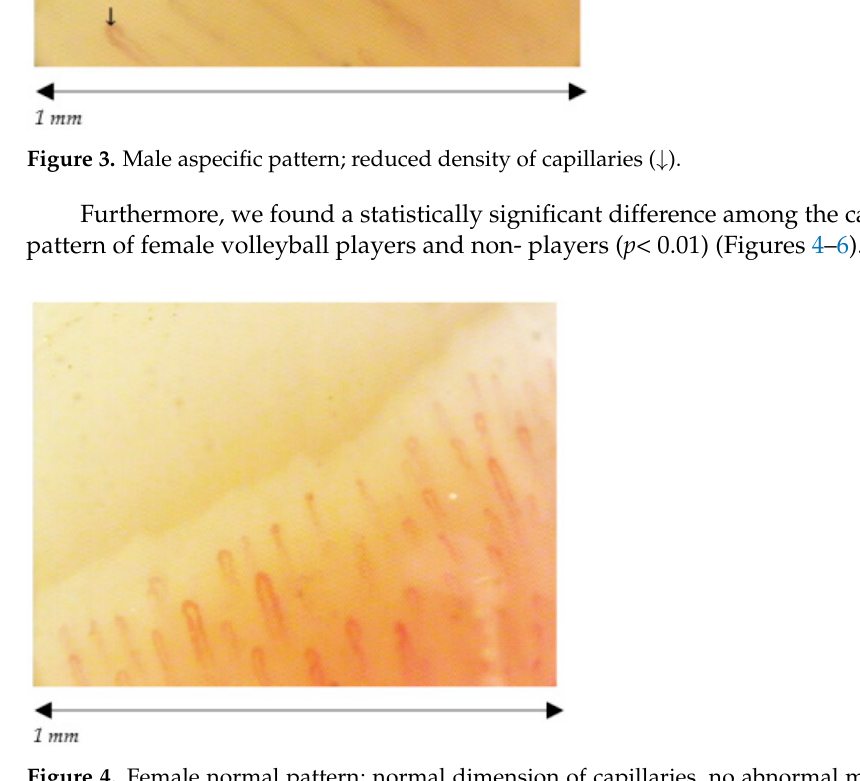
Figure 4. Female normal pattern; normal dimension of capillaries, no abnormal morphology, no hemorrhages .